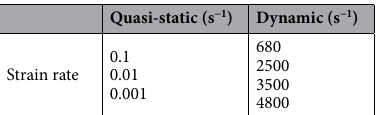
Table 3. 42CrMo steel physical